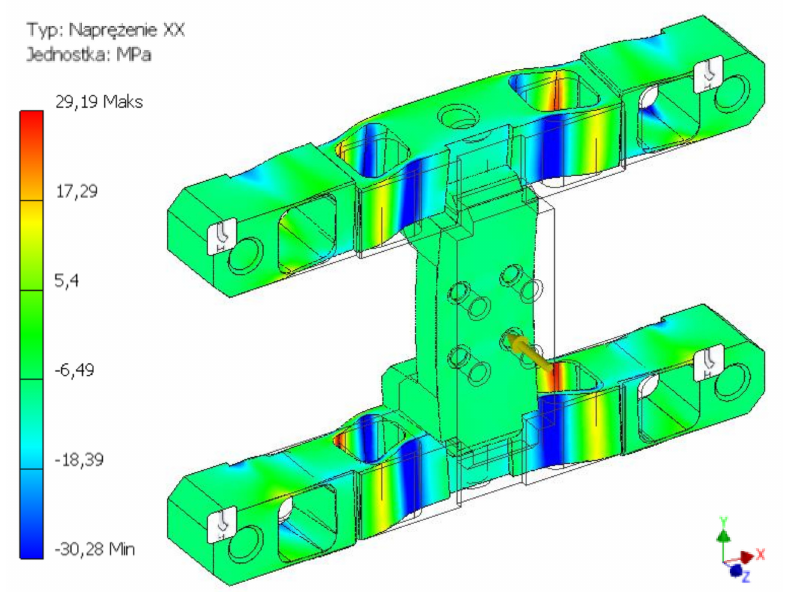
Figure 7. H-M-H strain map for the force value of 450 N acting along the Z axis.